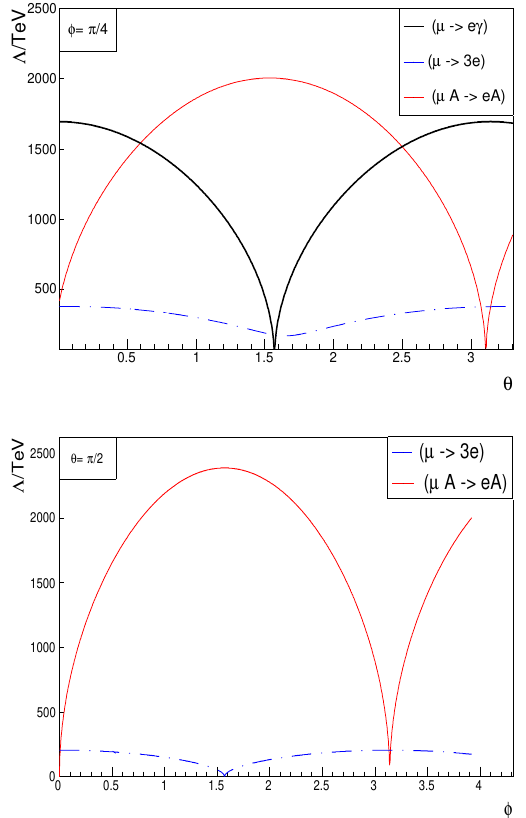
Figure 1 . The bound on the New Physics scale Λ NP from current constraints on µ → e L γ (thick black), µ → e L e L e L (dot-dashed blue) and µA → e L A (thin red), for New Physics parametrised